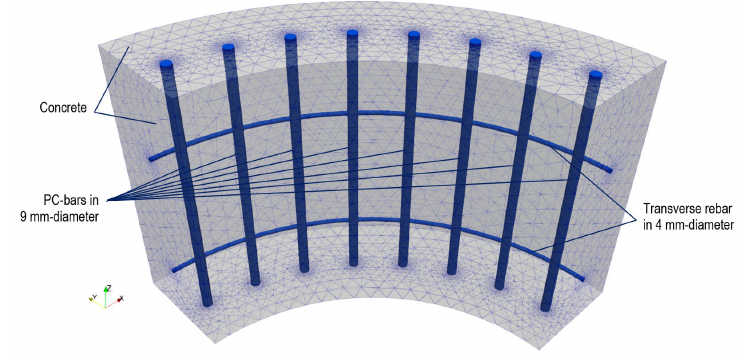
Figure 3. PC-bars and transverse rebars embedded in spun pile model.